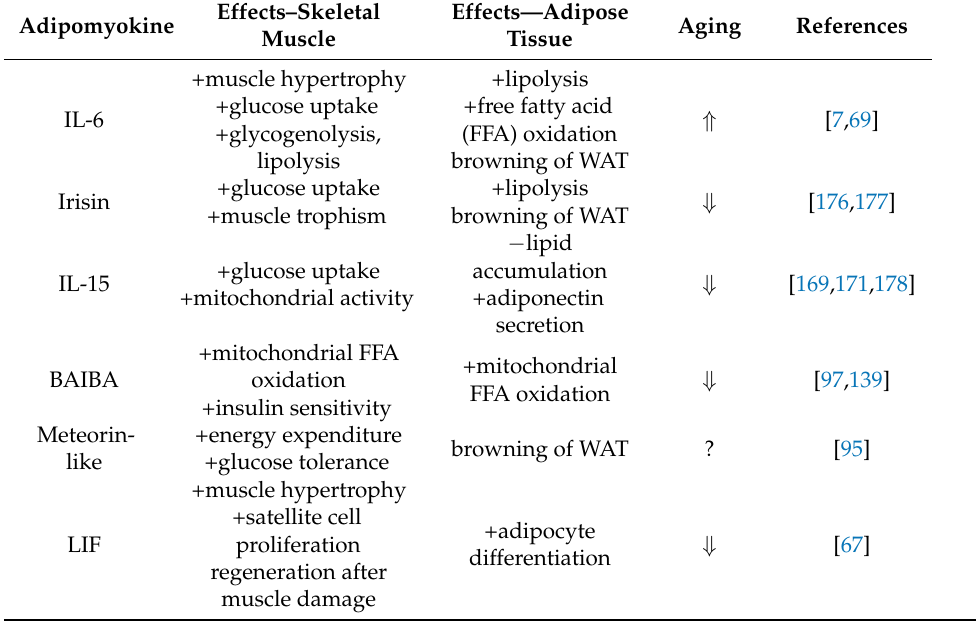
Table 2. Selected adipomyokines in muscle and adipose tissue